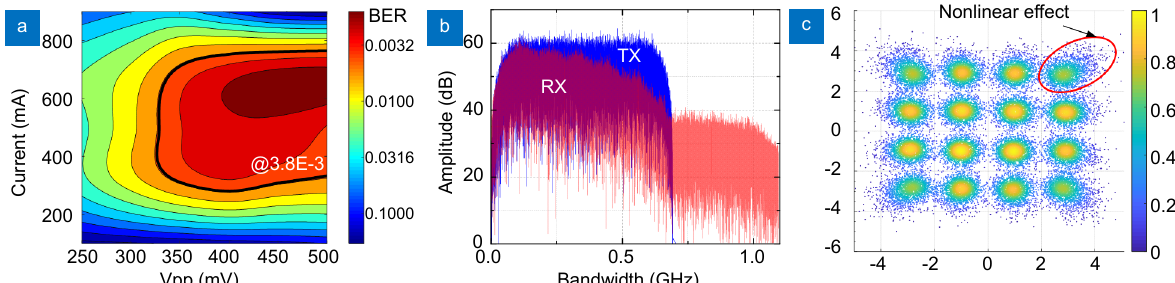
Fig. 4 | ( a ) The relation of the injection current–Vpp–BER in the SLD-based VLC system. ( b ) The frequency response of the received signal (RX) and the transmitted signal (TX). ( c ) The constellation diagram of the recovered signal without the first-stage equalizer showing nonlinear effects at the data rate of 2.4 Gbit/s using the setup of Fig.